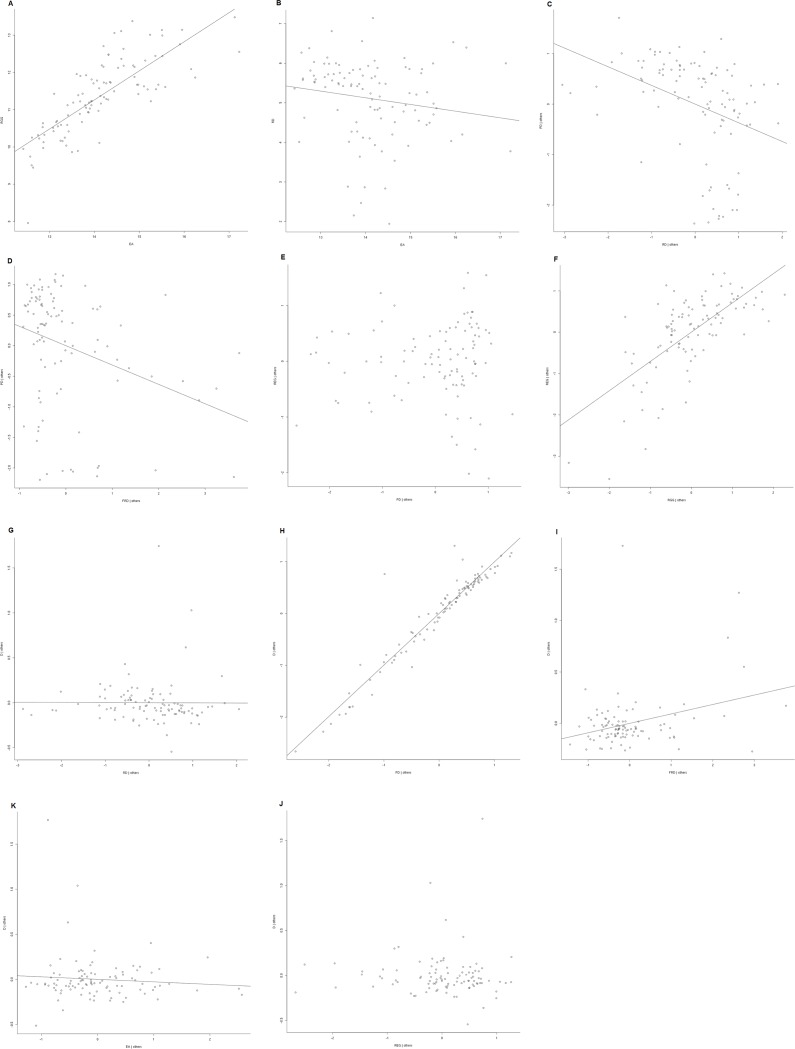
Panel results graphs.Panel with graphs of the simple regression and partial graphs of the multiple regression.